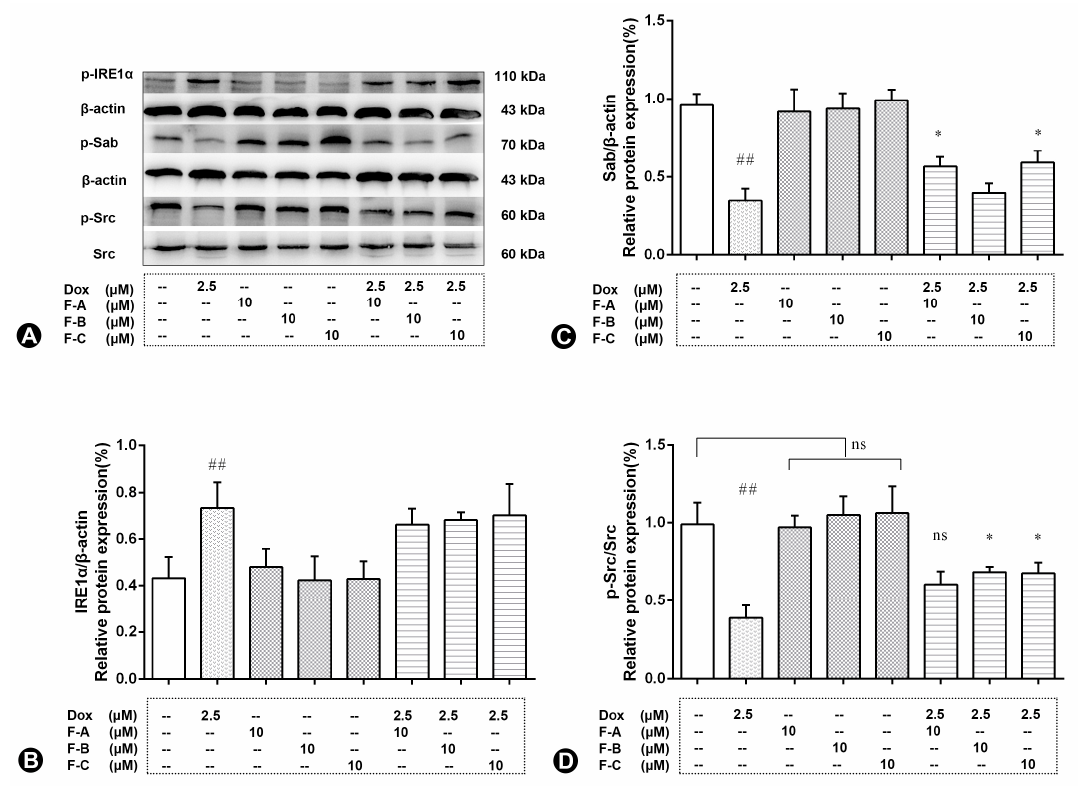
Figure 8. The effects of three flavonoids on Sab, p-Src, and p-IRE1 α protein expression level of Dox-treated H9c2 cells. Cells were pretreated with same concentrations of F-A, F-B, and F-C (10 µ M) for 1 h, then exposed to Dox for 24 h. Relative folds of Sab ( A , B ), p-Src ( A , D ), and p-IRE1 α ( A , C ). ( B ) The relative expression level of p-IRE α in Dox group significantly increased compared to the NC group ( p < 0.01). There was no significant activation of p-IRE α in the F-A, F-B, and F-C group without Dox. F-A, F-B, and F-C had no significantly protective effect to reduce Dox-induced p-IRE α protein phosphorylation. ( C ) The relative expression level of Sab in Dox group significantly decreased compared to the NC group ( p < 0.01). There was no significant change of Sab in the F-A, F-B, and F-C group without Dox. But F-A and F-C can significantly enhance the Dox-induced reduction of Sab in comparison to the Dox model group ( p < 0.05). ( D ) The relative expression level of p-Src in Dox group significantly decreased compared to the NC group ( p < 0.01). There was no significant change of p-Src in the F-A, F-B, and F-C group without Dox. But F-B and F-C can significantly enhance the Dox-induced reduction of p-Src in comparison to the Dox model group ( p < 0.05). Results are mean ± SEM from three independent experiments. ## p < 0.01 vs. control, * p < 0.05 vs. Dox group. ns, not